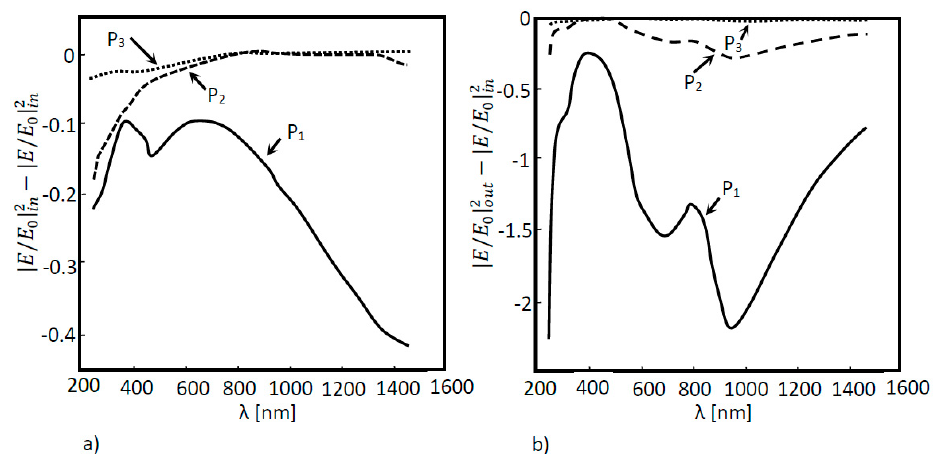
Figure 8. Absorption as a function of the wavelength for the simulated 3D a-Si solar cell structure. Measures were performed in three different positions: P 1 , P 2 and P 3 for two different situations: ( a ) without a nanoantenna and ( b ) with a nanoantenna.